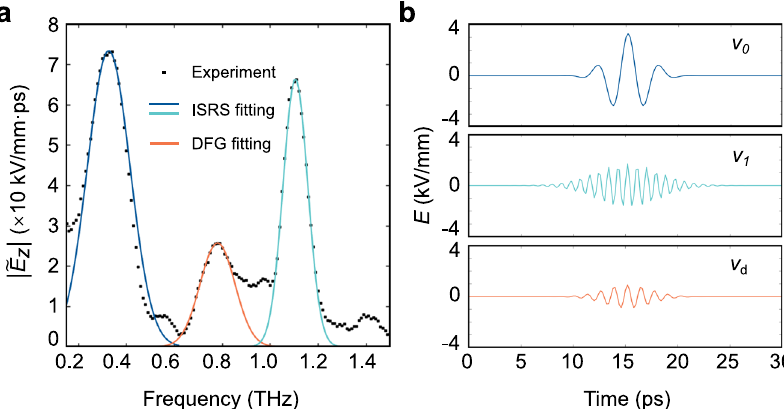
Fig. 5 Fitting of measured DFG spectrum and comparison of second-order nonlinear susceptibility. a Spectrum of the THz waves at position x 1 and Gaussian fi ttings of all the three frequency components. Blue and green curves fi t v 0 and v 1 , while the red curve fi ts the DFG signal v d . b Corresponding inverse Fourier transform showing time domain oscillations for v 0 , v 1 , and v d .